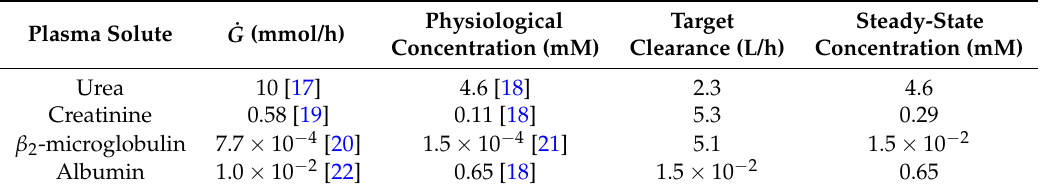
Table 1. Generation rates ˙ G , physiological concentrations, target clearance rates, and predicted steady-state concentrations during continuous nanomembrane dialysis for selected uremic toxins as well as albumin. "Physiological concentrations" refer to reference concentrations expected of patients in good health. Values may vary from patient-to-patient and serve here only as approximations of averages for a mean body weight of 70 kg. An example target clearance calculation is supplied in Equation (15). Steady-state concentrations are predicted using Equation (7) for β < 0.2 (see Equation (9)) and (11)